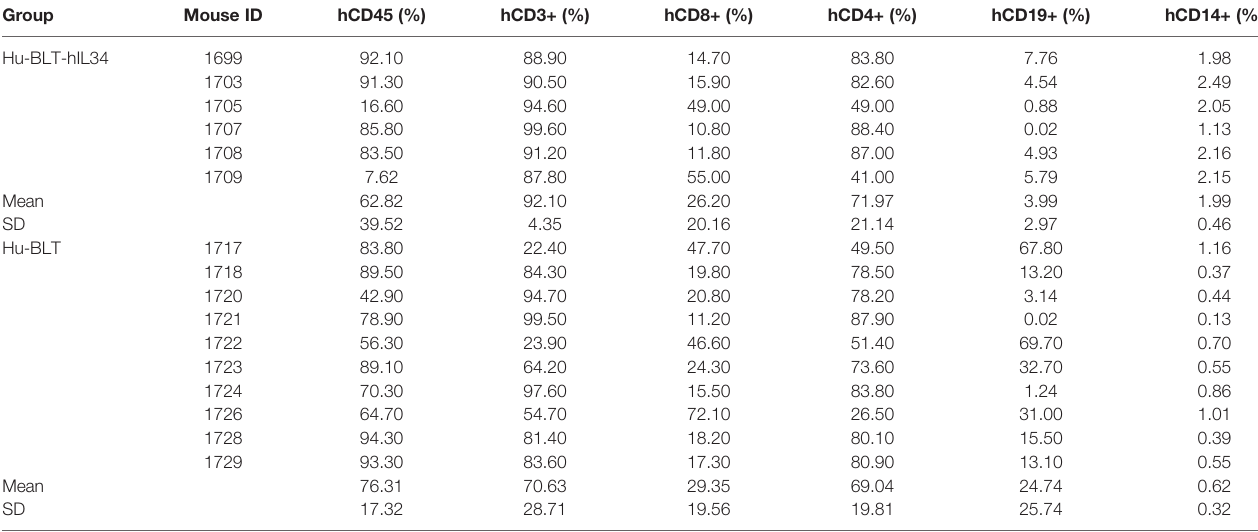
TABLE 1 | The blood human immune cells reconstitutions of hu-BLT-hIL34 and hu-BLT mice. Group Mouse